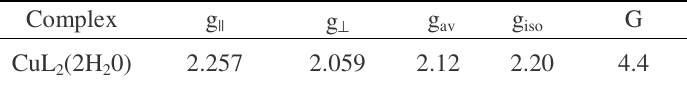
Table 4. ESR data of the Cu(II) complex of the ligand